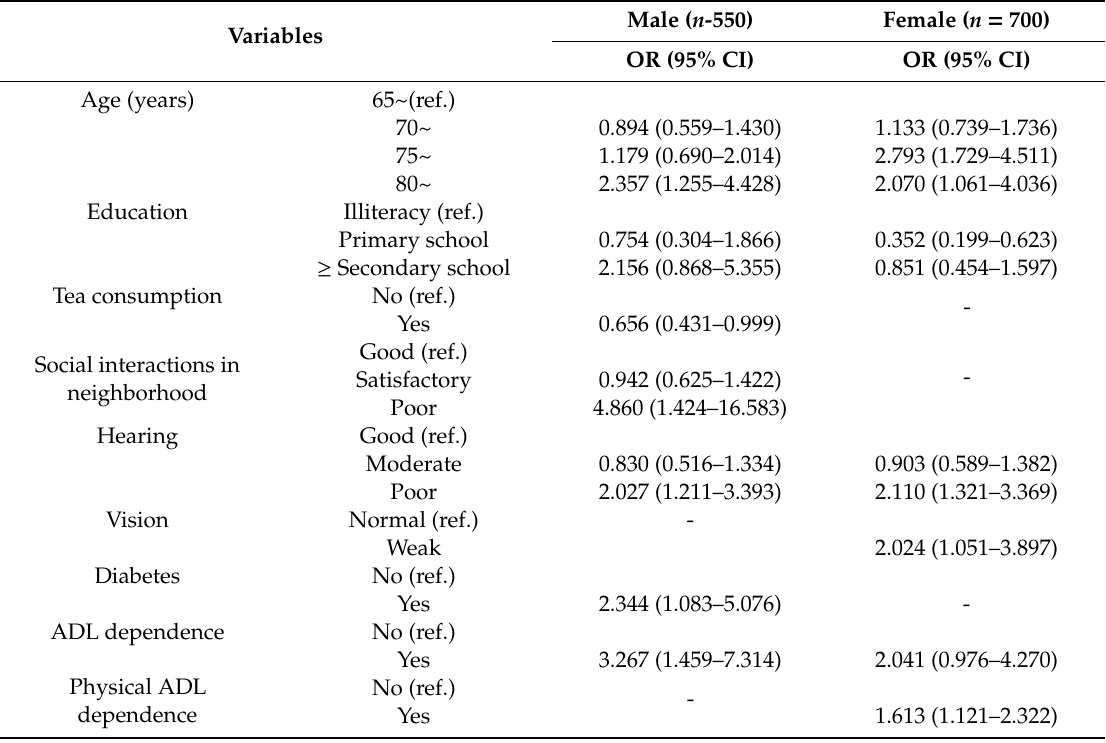
Table 6. Multivariate analysis of factors associated with cognitive